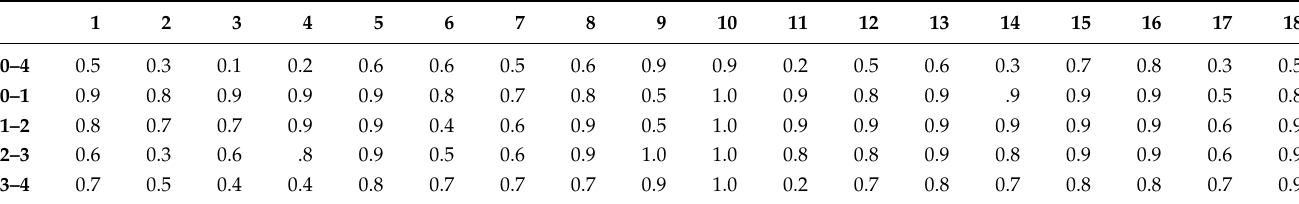
Table 6. Correlation coefficients between mosaic layers.